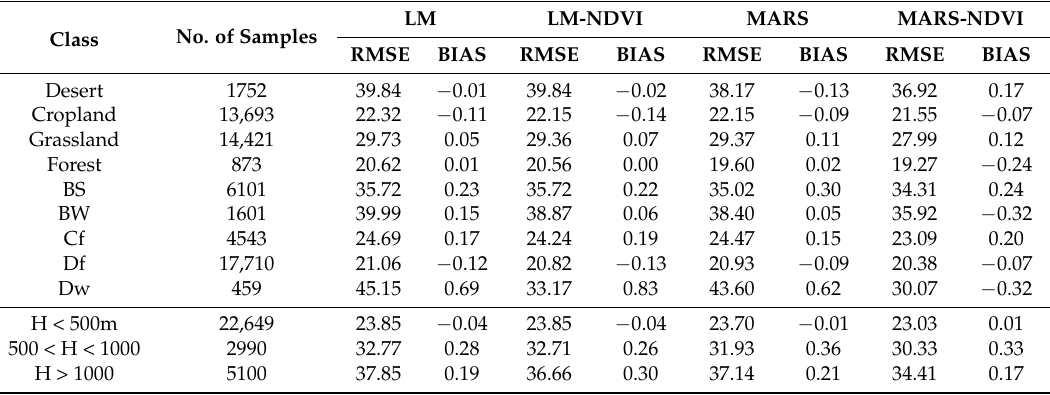
Table 3. Summary of statistics of the four developed models for the different land cover types, climate types, and surface elevations (H). Semi-arid climate (BS); desert climate (BW); temperate climates (Cf); continental climates (Df); and dry winter continental climates